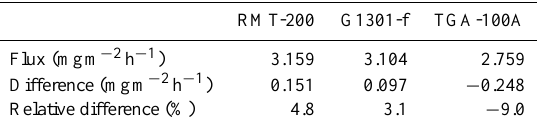
Table 6. Same as Table 5, but data was selected from between 9 June and 29 June. Prototype-7700 was out of operation during this period.